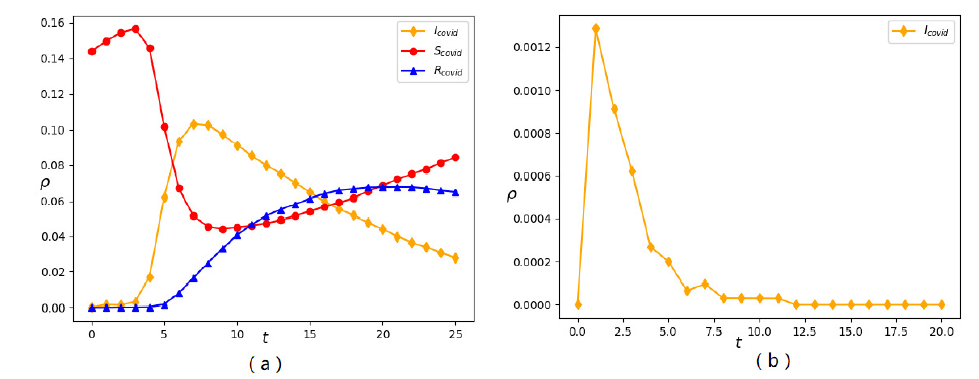
Figure 9. ( a ) The density change curve of I covid , S covid , and R covid with time through simulating the knowledge dissemination model when a new discovery is widely spread in the COVID-19 field. Here, m = 50, λ = 0.6, λ 1 = 0.3, λ h = 0.05, r = 0.1, r h = 0.15, j = 0.8, z = 0.8, and u = 0.05. ( b ) The density change curve of I covid with time when a new discovery is not widely disseminated or is of little value in the COVID-19 field. Here, m = 50, λ = 0.01, λ 1 = 0.01, r = 0.3, r h = 0.15, j = 0.8, z = 0.8, and u = 0.05. The ordinate ρ of Figure 9a,b represents the proportion of I covid , S covid , and R covid in the COVID-19 field to all articles in the